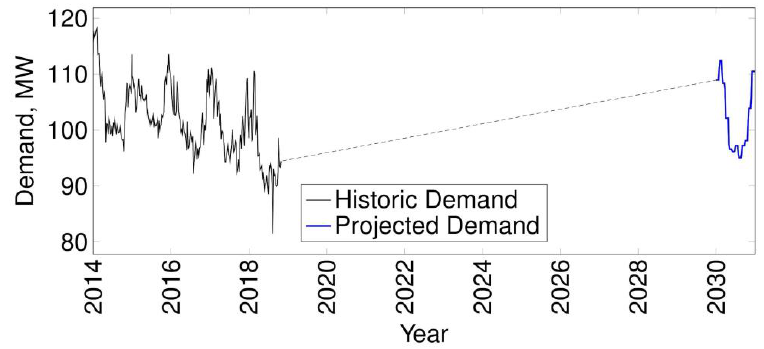
Figure 2. Historical and projected Humboldt County load used in this model.